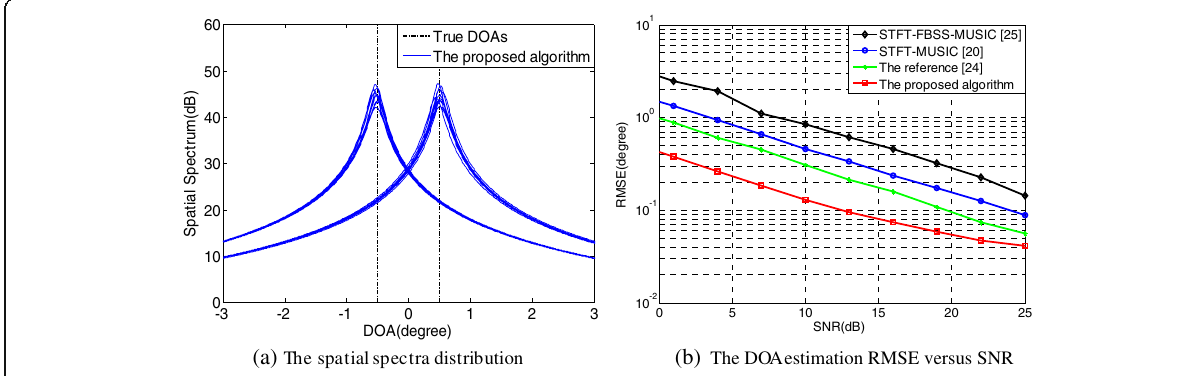
Fig. 5 The angular resolution of the proposed algorithm (DOA spacing: 1 °), ( a ) the spatial spectrum distribution, ( b ) the RMSE of DOA estimation versus